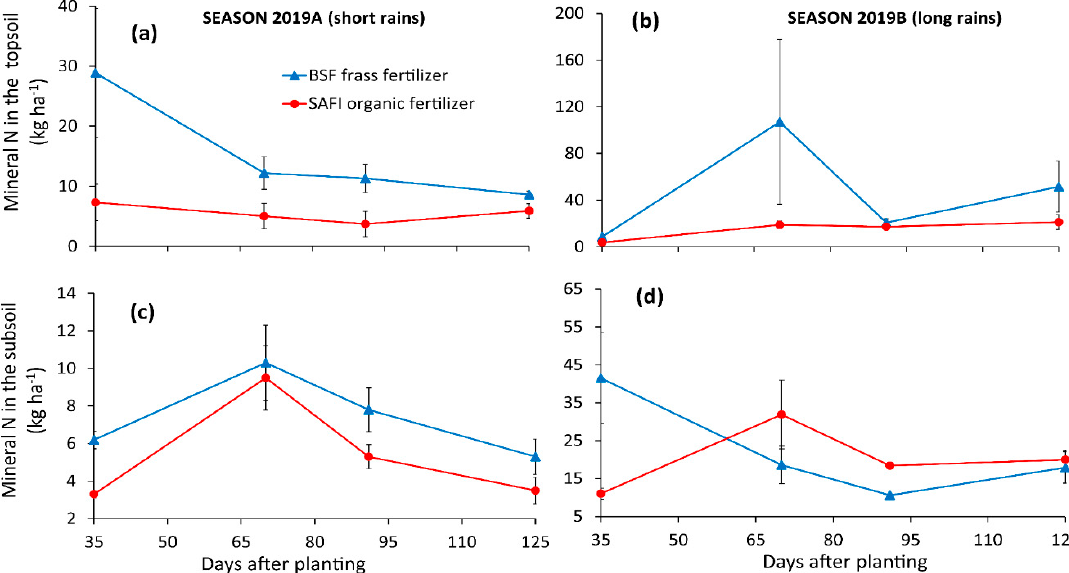
Figure 3. Mineral nitrogen content in the topsoil (0–20 cm) ( a , b ) and subsoil (20–40 cm) ( c , d ) layers following application of BSF frass and SAFI organic fertilizers during the short and long rain season experiments.